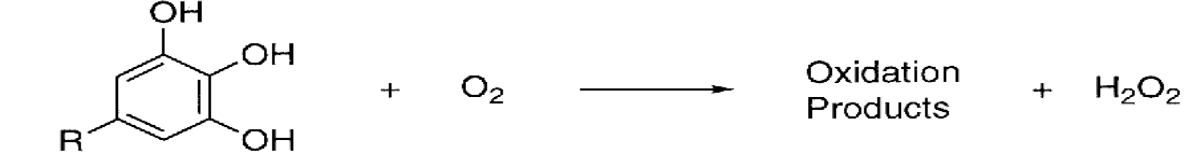
Figure 3. Proposed mechanism of oxidation of gallocatechin (Source: Nakayama et al. [61]). (b)